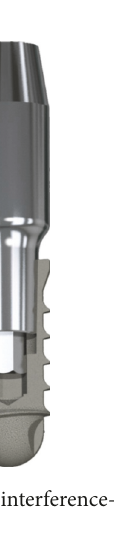
Figure 1: The sandblasted-acid-etched surface of the implants used in this study, at different magnification: (a) × 100; (b) × 200; (c) × 500; (d) × 1000. Implant surface was treated with a sandblasting process producing an average roughness 𝑅 𝑎 of 2.5 𝜇 m: fixtures were blasted with alumina particles. Sandblasting was followed by a decontamination treatment series, including a passivation process with nitric acid.